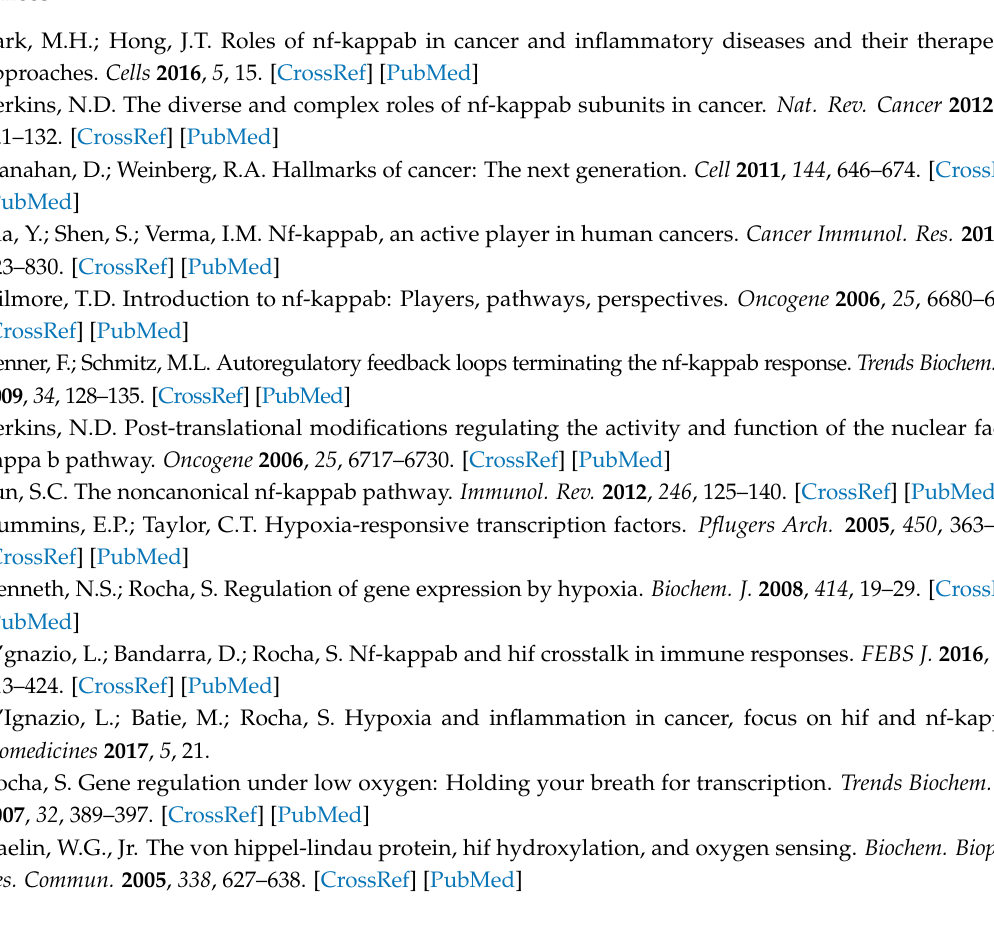
treatment. Figure S3: Validation of p52 siRNA-mediated knockdown and LIGHT effects on E2F1 expression. Figure S4: HIF-2 α κ B motif analysis and validation of NF- κ B subunit, p52, ChIP specificity at the HIF-2 α and HIF-1 α promoters. Table S1: Putative κ B genomic